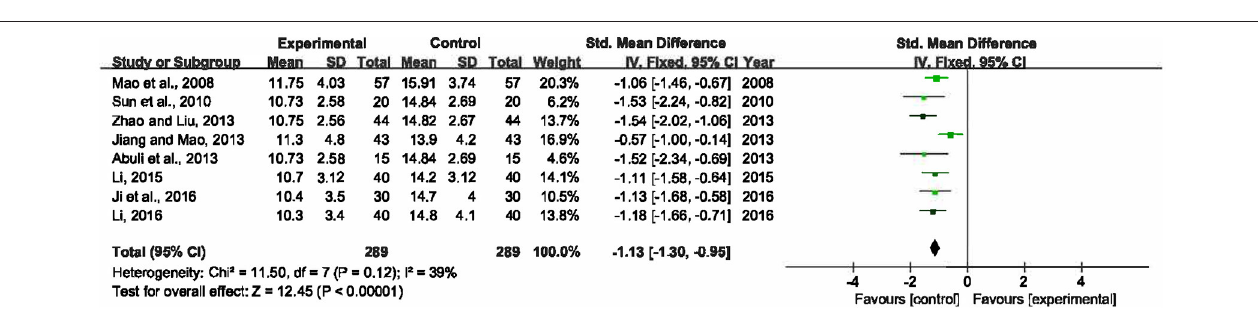
FIGURE 3 | Forest plot of 28-day mortality in sepsis patients treated with XBJ + UTI therapy and UTI alone.